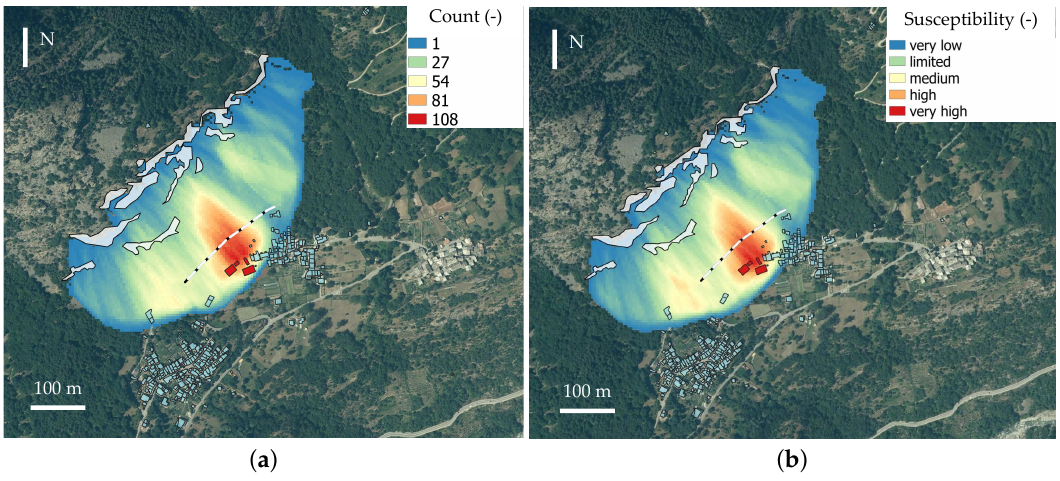
Figure 7. Two outputs of the time-independent hazard maps obtained through the QPROTO plugin: ( a ) The count file relates to the numbers of visibility cones that view a specific cell of the slope. It can be seen that the middle part of the cliff (uphill the buildings involved in the 2011 events) has the highest visibility; ( b ) in the susceptibility raster, the same result can be found but in a qualitative scale ranging from very low to very high